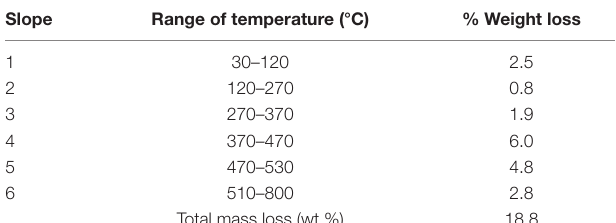
TaBle 2 | Percentage of weight loss for different stages of thermal behavior of halloysite loaded with dodecylamine inhibitor. slope